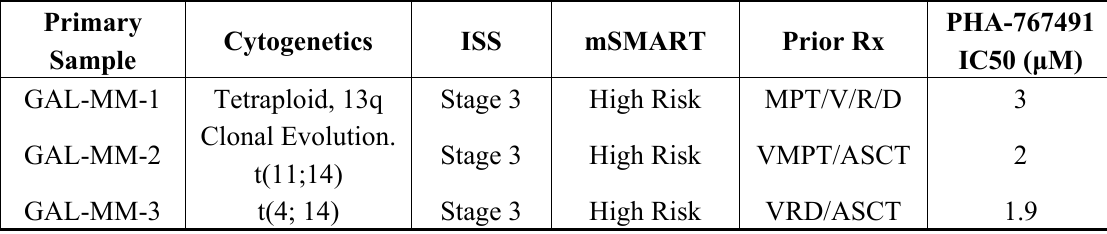
Table 2. Anti-proliferate activity of PHA-767491 in multiple myeloma primary